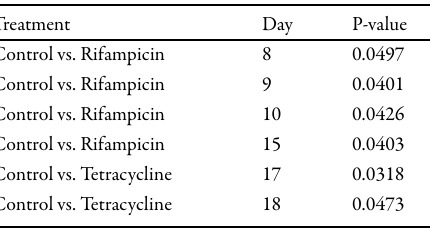
table 3. significant differences detected with the tukey-Kramer analysis between